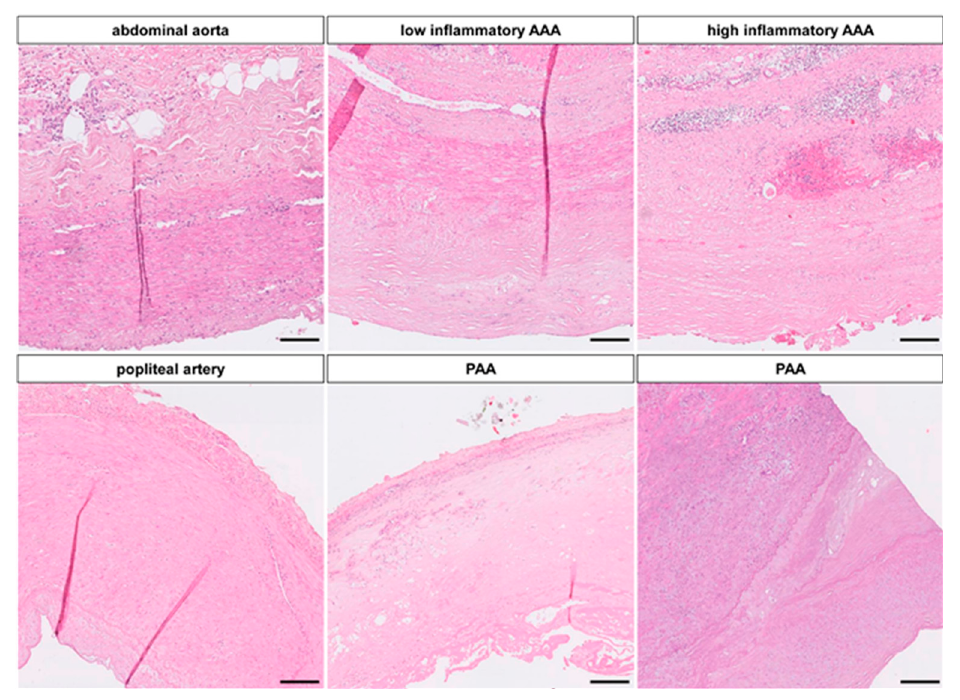
Figure 2. Cont. Figure 2. miRNA expression in aneurysm disease: ( A ) miR expression in abdominal aortic aneurysm (AAA), PAA and their respective control tissues normalized to endogenous controls U6 and RNU48 show significant down-regulation for miR-362, -19b-1, -194, -769, -21 and -550 in AAA and down-regulation for miR-19b-1 and -769 in PAA. miR-362 and -194 show no difference and miR-550 and -21 are up regulated in PAA. This is more obvious on the log 10 fold changes, which highlights the differential regulation of miR-550 and -21 between AAA and PAA; ( B ) Both miRs are located to the VSMCs of the intima/media of the vessel and aneurysm respectively and both show enrichment in PAA in comparison to popliteal artery and AAA/control artoa; ( C , D ) While miR-550 is down-regulated in AAA regardless the grade of inflammation, miR-21 shows even up regulation in lower inflammatory specimen compared to high inflammation and control tissue. ( p = probability; * = p < 0.05; magnification 40×; scale bar 100 µm). 2.1.3. miR-Signature in Popliteal Artery Aneurysm (PAA) Differs Significantly from AAA To shed additional light on the implications of these identified miRs in aneurysm disease, we compared miR-expression in paired probes of PAA vs. non-aneurysmatic artery. This rare, yet clinically important, entity showed a more homogenous morphology on the histologic level with complete loss of the muscular artery phenotype (Figure 1). From a total of 15 analyzed samples, 8 were available for miR-expression analysis. Expression of miR in PAA showed considerably differing trends from AAA tissue, although statistical significance was not achieved (Figure 2). miR-194 and -362 did not differ between aneurysm and control. MiR-550 and miR-21 were up-regulated, miR-19b-1 and -769 were down-regulated in PAA in comparison to non-aneurysmal control tissue.